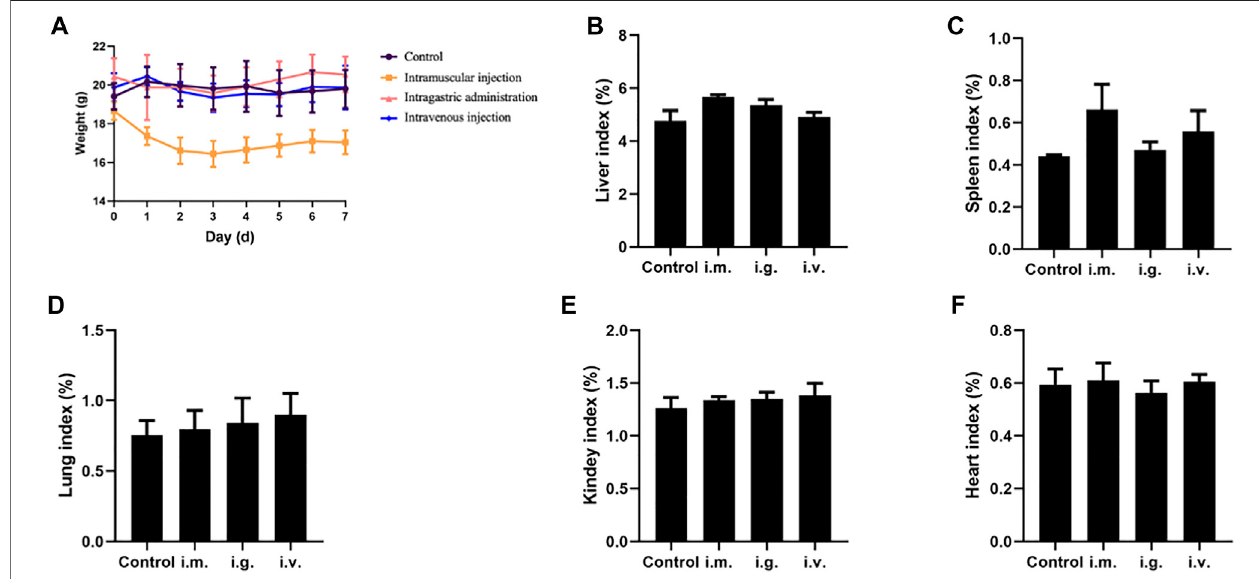
FIGURE 3 | Histological examination of tissues (heart, liver, spleen, lung, and kidneys) from the mice exposed by intramuscular (i.m.) injection, intragastric (i.g.) administration, and intravenous (i.v.) injection at day 7. The scale bar is 100 μ m.